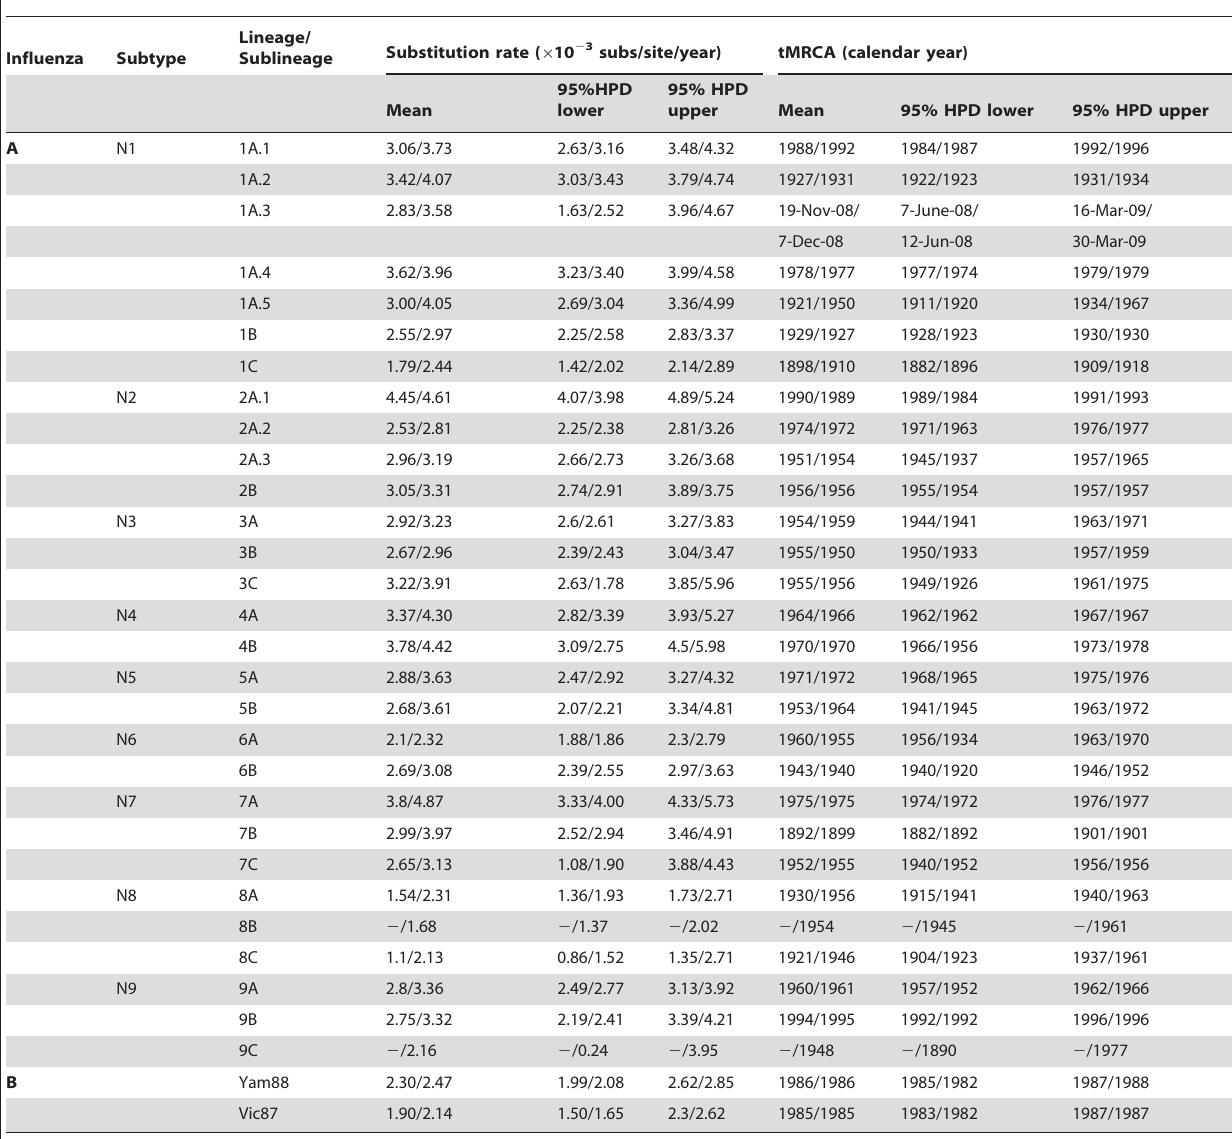
Table 2. Substitutions rates and tMRCAs of different lineages for influenza A and B NA genes*.